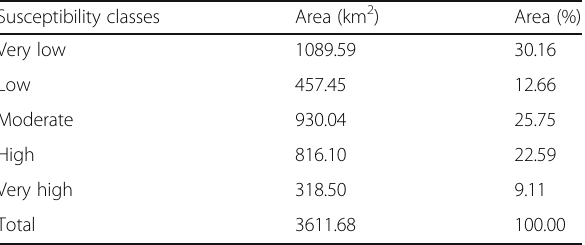
Table 5 Areas of susceptibility map